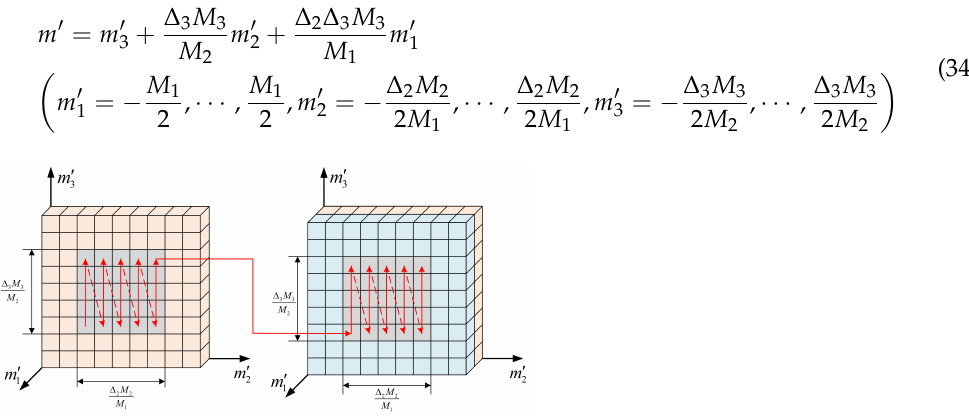
Figure 9. Data stitching of two-layer